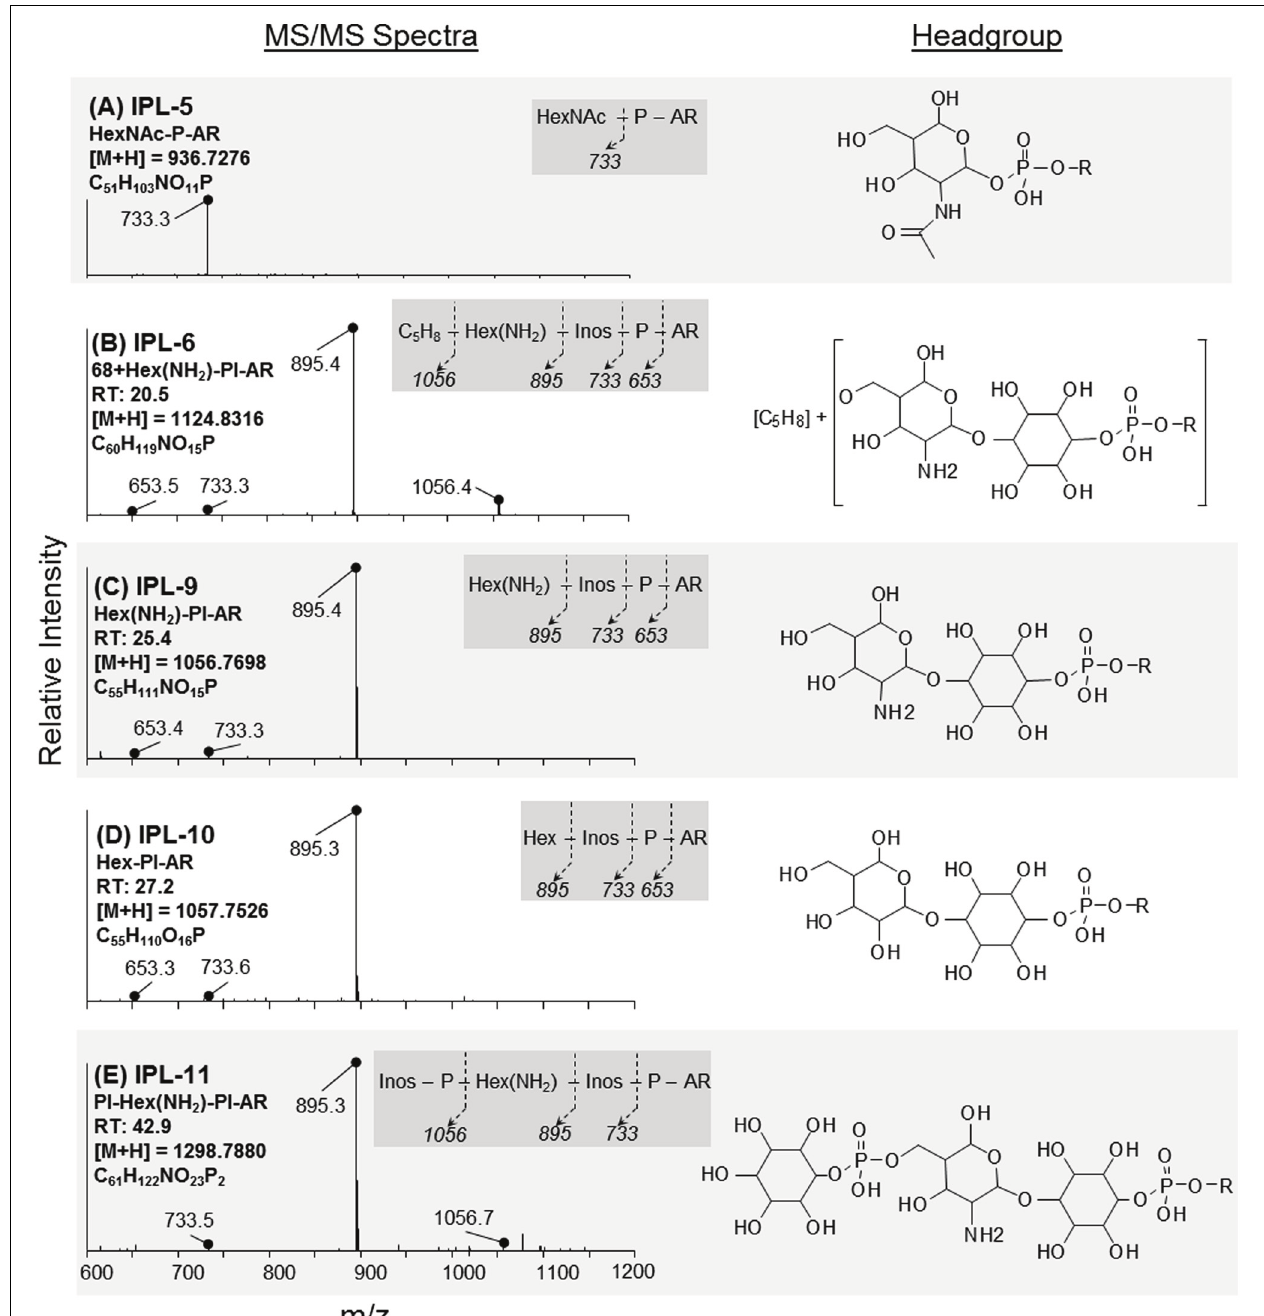
FIGURE 4 | Identification and tentative structural assignment of novel AR IPLs produced by T. kodakarensis . Fragmentations, retention times, and parent ion masses of AR IPLs were identified after ion trap-MS and Q-TOF-MS. MS/MS spectra (left column) revealed major ions that corresponded to fragmentation of headgroup moieties as denoted in the dark grey box; Inos = inositol. Tentative molecular structures are provided in the right column, where R = archaeol. (A) IPL-5; the MS/MS spectrum is consistent with the P-HexNAc headgroup reported by Ferrante et al. (1986). (B) IPL-6; mass fragments of 895 and 1056Da are consistent with PI-AR and